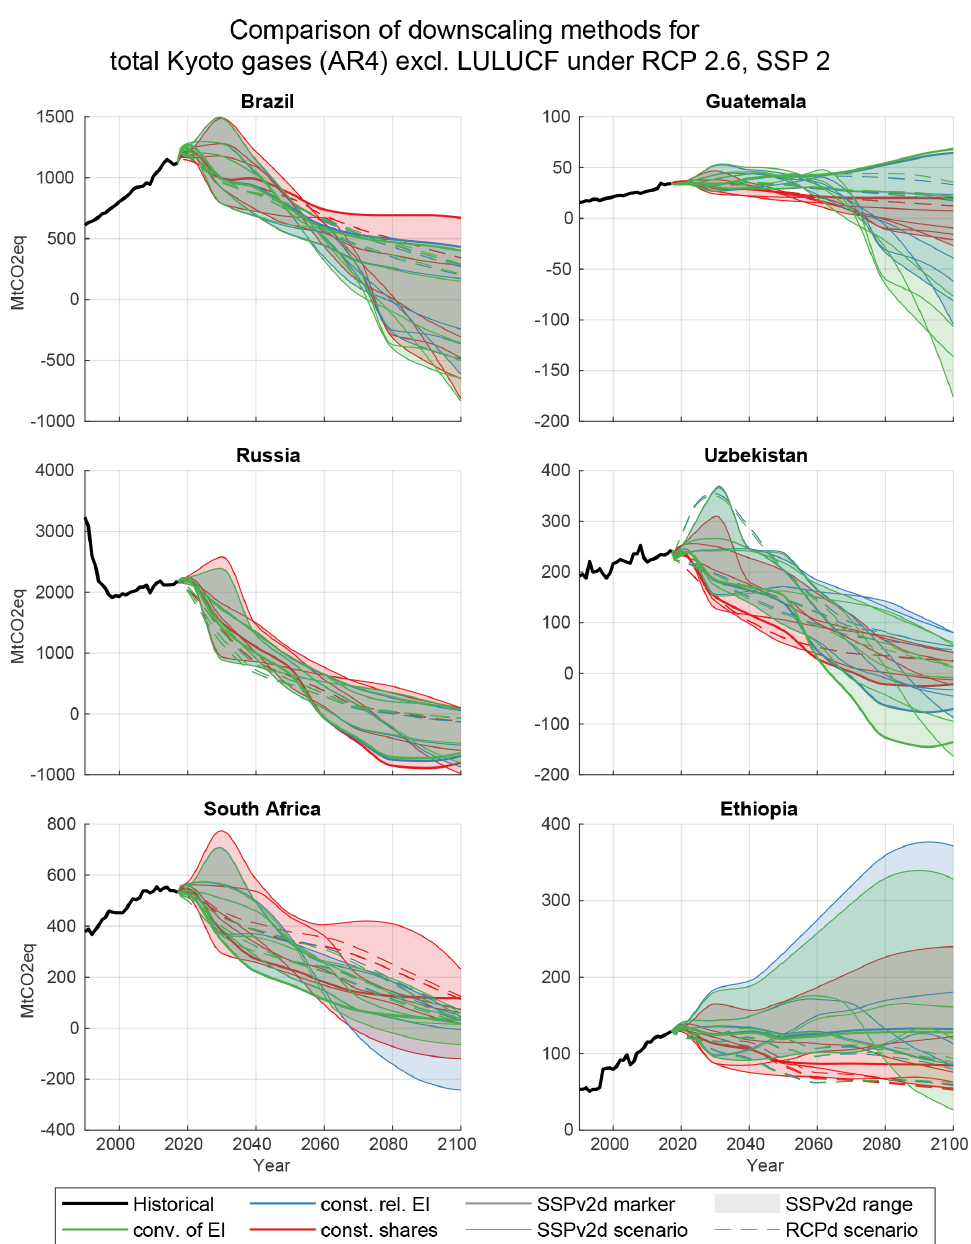
Figure 11. Influence of the downscaling method on country emissions for RCP2.6 and SSP2. Ranges are calculated over all IAM implemen- tations in SSPv2d. RCPd scenarios are shown as individual lines only (dashed). For the Latin America region the influence is comparable to the OECD region and mainly visible in the second half of the century (top panels). The Middle East and Africa region shows a strong influence of the downscaling method (bottom